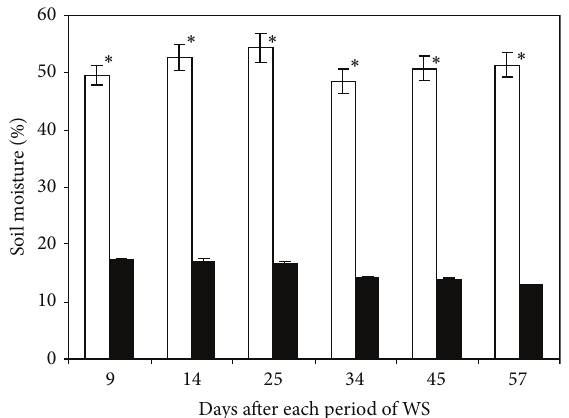
Figure 1: Soil moisture (%) in watered ( ◻ ) and nonwatered pot soils ( ◼ ) of banana plants. Data are means ± SE and each value was determined by three TDR probes with three replicates per treatment (𝑛 = 9) (one probe per pot). Data were compared for each date using the least significant difference (LSD) test. Significant differences at 𝑃 ≤ 0.05 are represented by an asterisk ( ∗ ). WS: water stress.